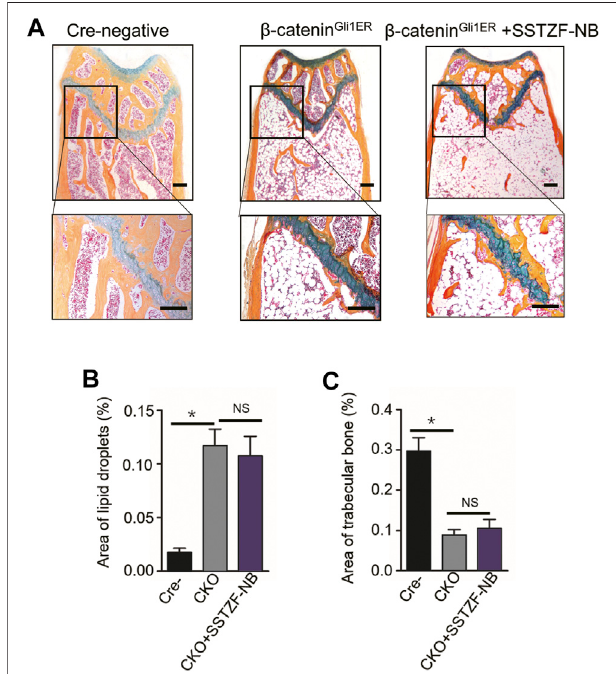
FIGURE 6 | In fl uence of SSTZF-NB on increases of trabecular bone formation and decreases of fat accumulation in the area of the chondro- osseous junction inhibited in β -catenin Gli1ER mice. (A) ABH staining of each group. Scale bar: 1000 μ m. Morphologic quantitative analyses of (B) lipid droplet area and (C) trabecular bone area. NS: no signi fi cant difference. * p < 0.001.